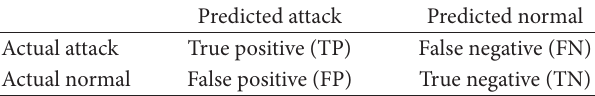
Table 4: Confusion